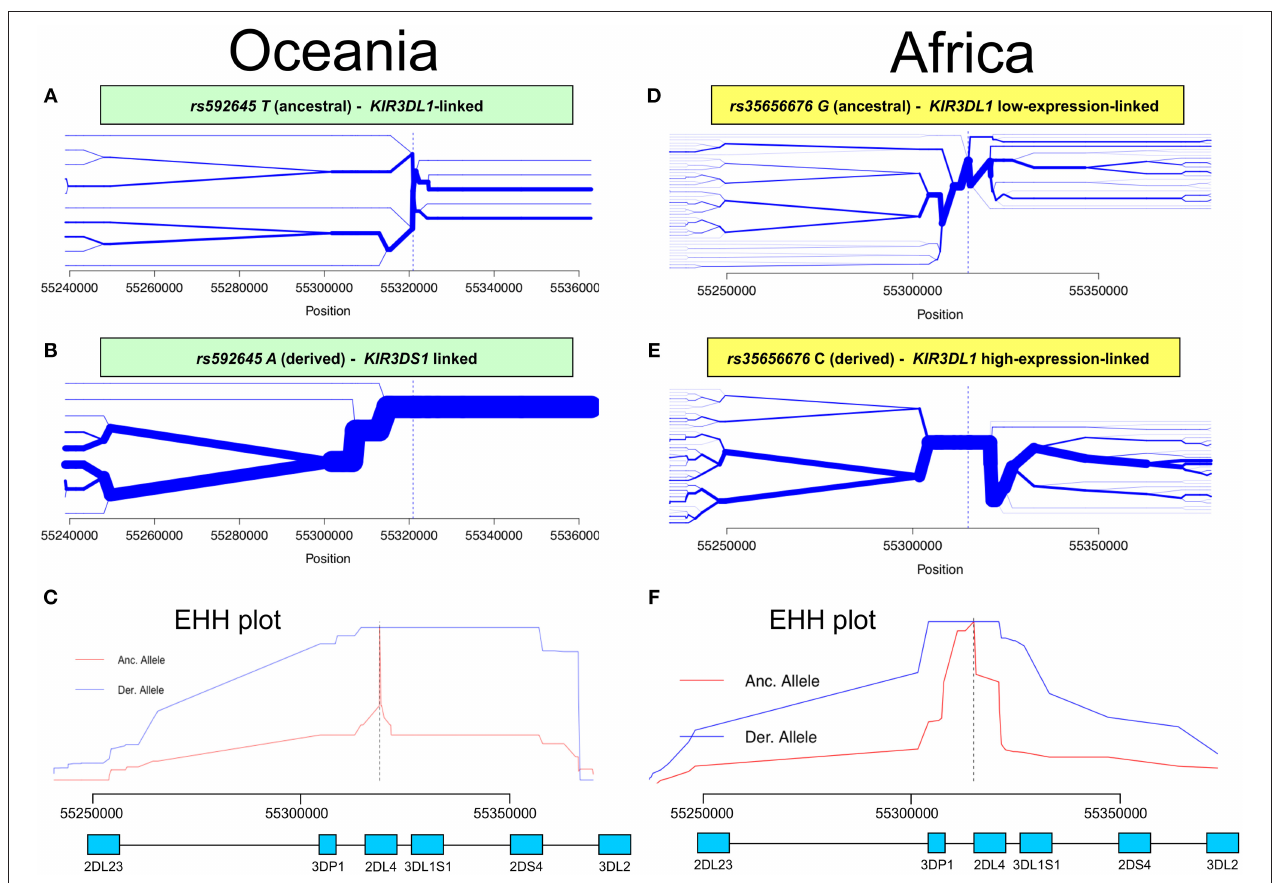
FIGURE 3 | Extended haplotype homozygosity (EHH) analysis points to ongoing positive selection in Oceania and Africa. Haplotype bifurcation diagrams for ancestral (A) and derived (B) alleles of rs592645 showing conserved haplotype associated with the derived allele, but not with the ancestral. The thickness of the line denotes haplotype frequency. (C) . EHH plot for rs592645 showing decay of haplotype homozygosity in which the derived allele A is under selection and sweeping to fixation. Haplotype bifurcation diagrams for ancestral (D) and derived (E) alleles of rs35656676 showing conserved haplotype associated with the derived allele, but not with the ancestral. (F) EHH plot for rs35656676 showing decay of haplotype homozygosity in which the derived allele C is under selection and sweeping to